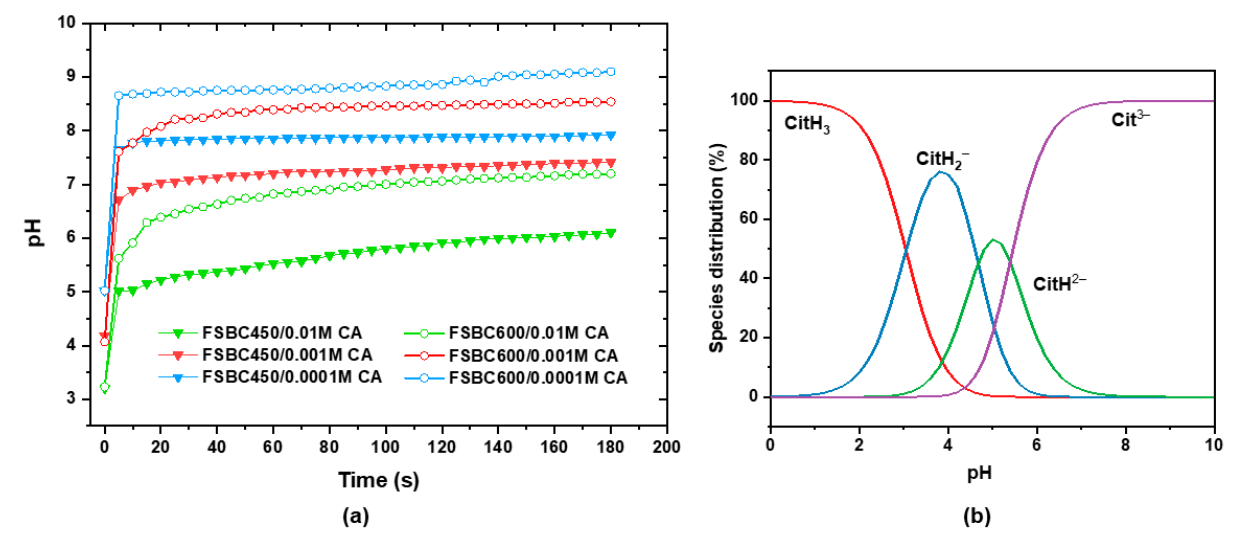
Figure 5. ( a ) The suspension pH when FSBC-450 and FSBC-600 were dissolved in 0.01, 0.001, and 0.0001 mol·dm − 3 citric acid solution. ( b ) pH distribution diagram for citric acid (CA, CitH 3 ).